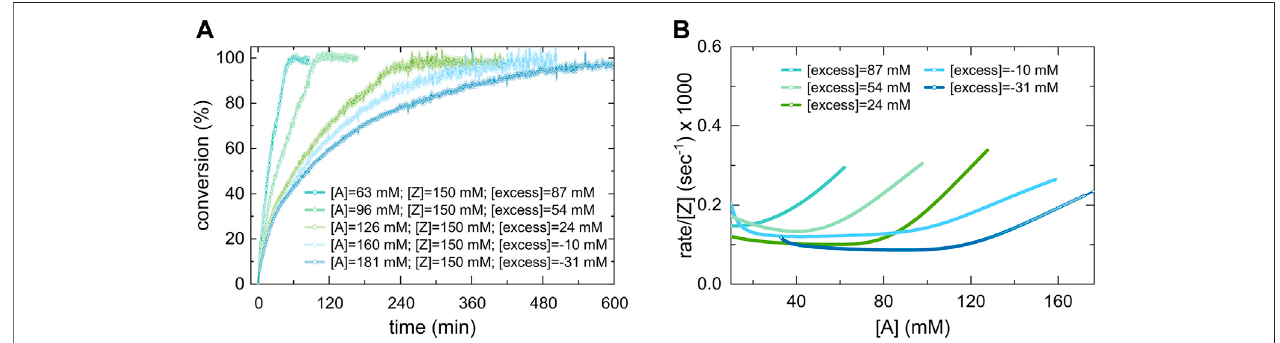
FIGURE 10 | Kinetic pro fi le of different-excess-experiments of the copper(I) catalyzed 5-bismuth(III) triazolide formation using A [2]. (A) Variable [A] concentration experiment, conversion vs. time. (B) rate/[Z] vs. A [2], the overlapping of the [excess] trials in the region of higher conversions signalizes a near to zero-type order in acetylide [A] substrate. Whereas, in the initial kinetic regime (at low conversions) the acetylide [A] shows non-zero rate